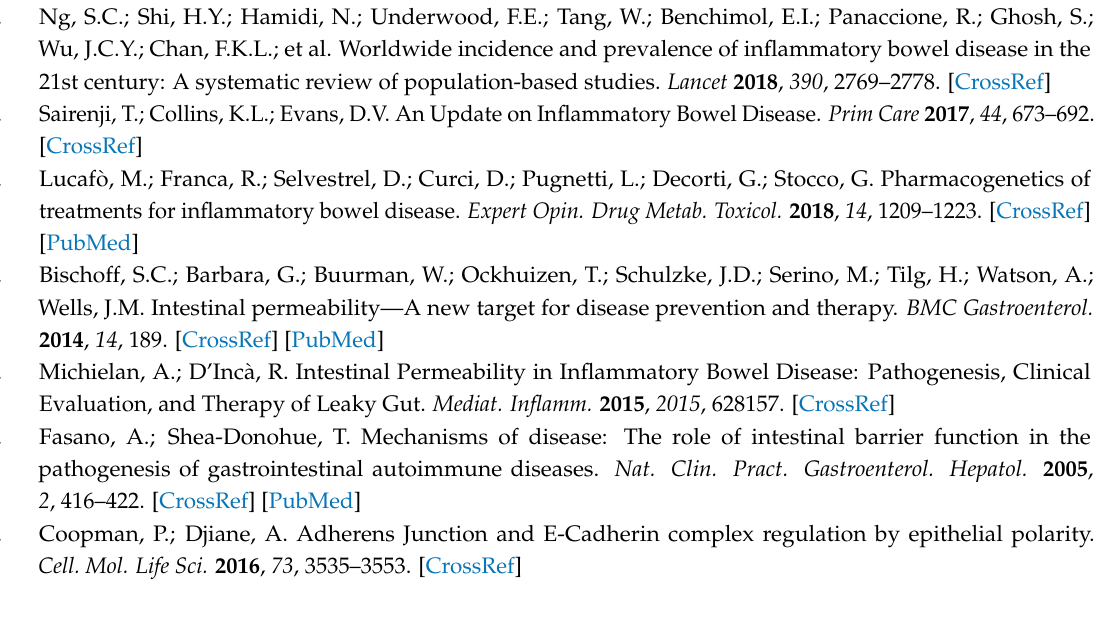
Figure S1: MBCP reduces intestinal permeability in DNBS-induced colitis in mice. Author Contributions: G.C.T.; P.S.; and E.N.: conceived and designed the experiments; S.L.; E.P.; D.V.; M.M.; R.C.; F.M. and S.D.M.: performed the experiments and analyzed the data; P.S. and F.B.: wrote the paper. G.C.T.; P.S.; E.N.; and F.B.: discussed and confirmed the final manuscript. Funding: This work was supported by a grant: “Combattere la resistenza tumorale: piattaforma integrata multidisciplinare per un approccio tecnologico innovativo alle oncoterapie—CAMPANIA ONCO TERAPIE” Regione Campania and EiCURE-Regione